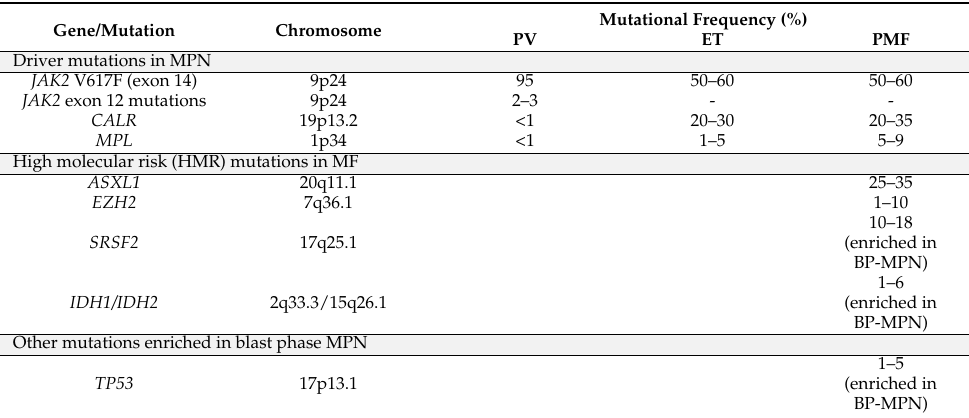
Table 1. Somatic mutations in myeloproliferative neoplasms (MPN). Mutation frequencies are indicated for polycythemia vera (PV), essential thrombocythemia (ET), and primary myelofibrosis (PMF) [27,28]. JAK2 , CALR, and MPL mutations are considered as driver mutations, while so-called high molecular risk (HMR) mutations confer adverse prognosis in myelofibrosis. BP-MPN blast phase